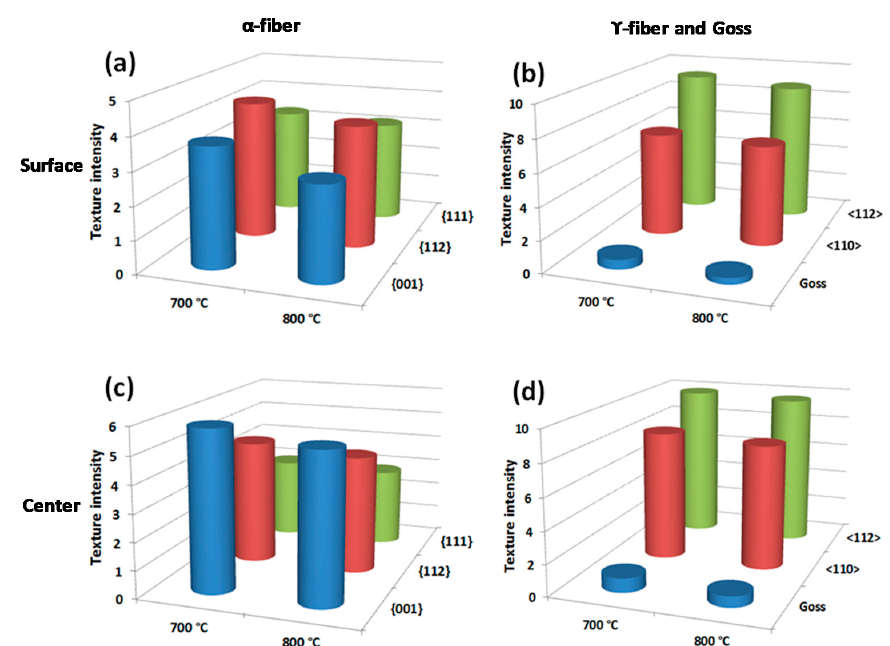
Figure 2. The influence of rolling temperature on the surface and centreline textures of the ferrite rolled strip: ( a ) α -fiber and ( b ) γ -fiber and Goss texture of surface layer; ( c ) α -fiber and ( d ) γ -fiber and Goss texture of center layer with rolling reduction of 40% at 700 and 800 °C with polyphosphate lubricant.